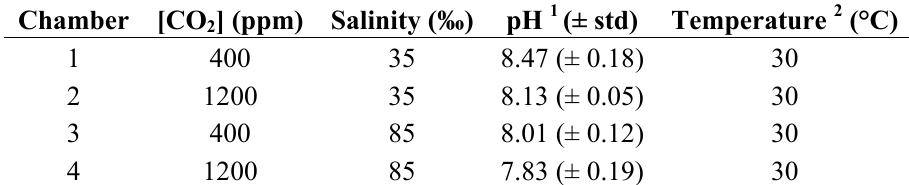
Table 1. Environmental parameters of microbialite